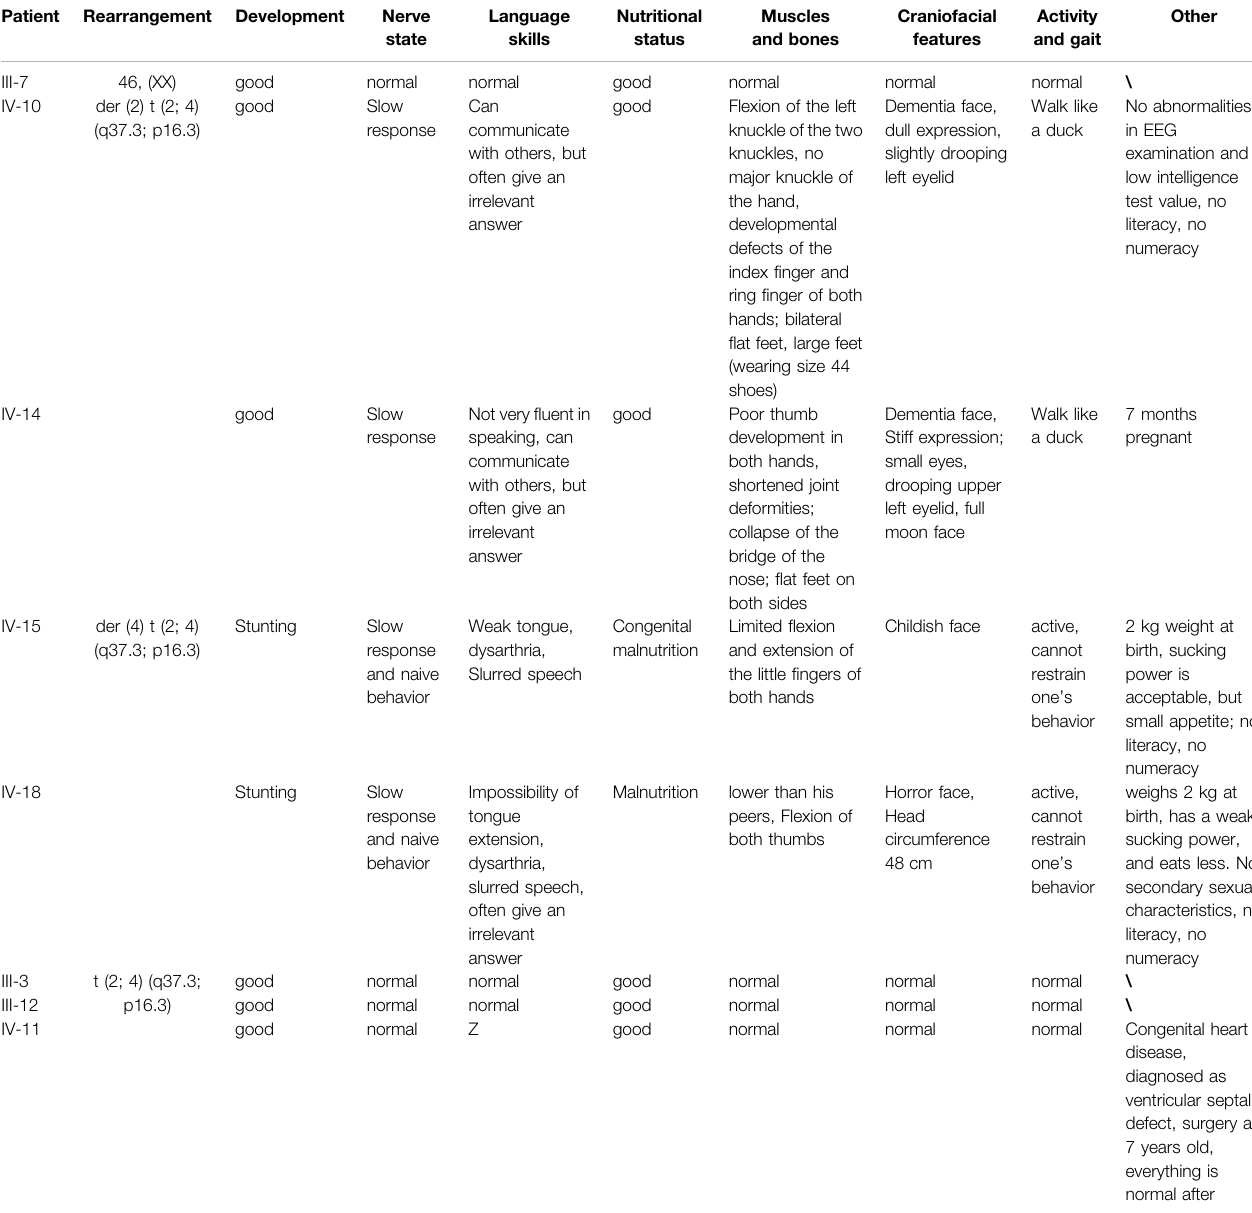
TABLE 2 | Differences among healthy, deletion, duplication, and translocation patients. Patient Rearrangement